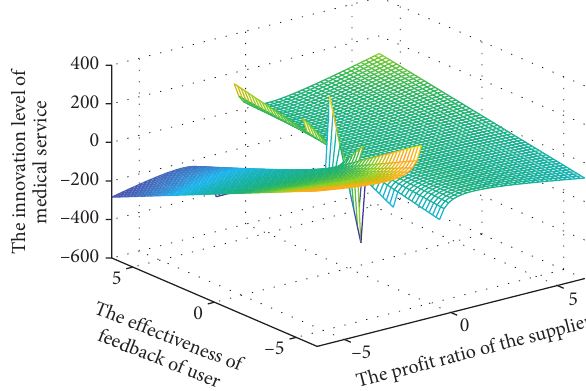
Figure 4: The innovation level of medical service in the decen- tralized strategy.